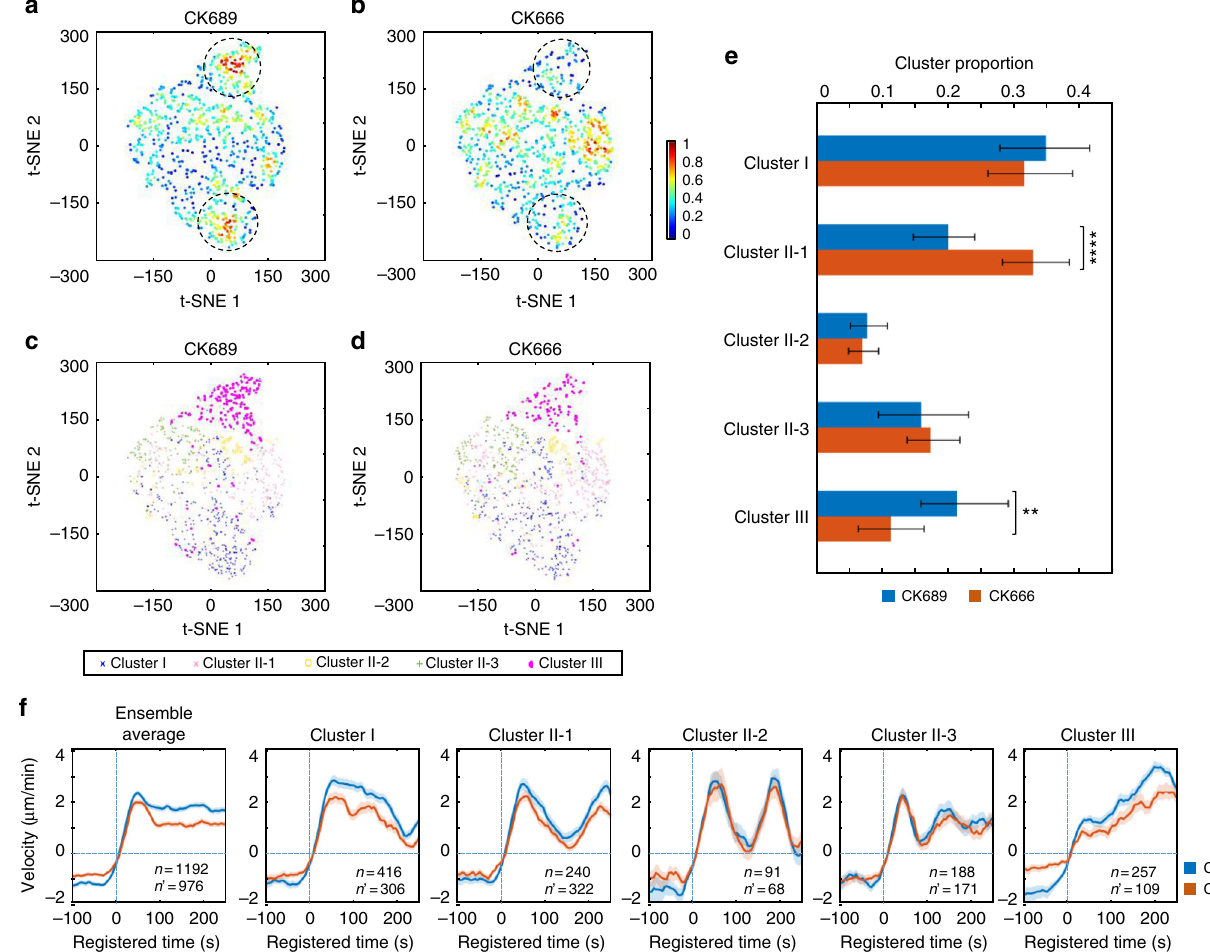
Fig. 5 Functional validation by pharmacological perturbation of Arp2/3. a – d t-SNE plots of autocorrelation functions of protrusion velocity time series overlaid with the density of data ( a , b ) and cluster assignments ( c , d ). e Comparison of the proportion of each cluster between CK689 (50 μ M, inactive control compound) and CK666 (50 μ M). The error bars indicate 95% con fi dence interval of the mean of the cluster proportions. ** p < 0.01 and **** p < 0.0001 indicate the statistical signi fi cance by bootstrap sampling. f Ensemble averaged velocity time series of entire samples and averaged velocity time series sampled in each cluster in CK689 or CK666-treated cells. All time series are registered with respect to protrusion onset ( t = 0). Solid lines indicate population averages. Shaded error bands indicate 95% con fi dence intervals of the mean computed by bootstrap sampling. n and n' indicate the number of time series sampled in each cluster for CK689 and CK666, respectively. The numbers of cells used in the analysis are both 10 (CK689 and